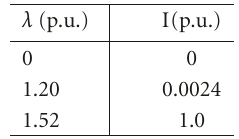
Table A.4: Transformer saturation characteristic of test system 1.